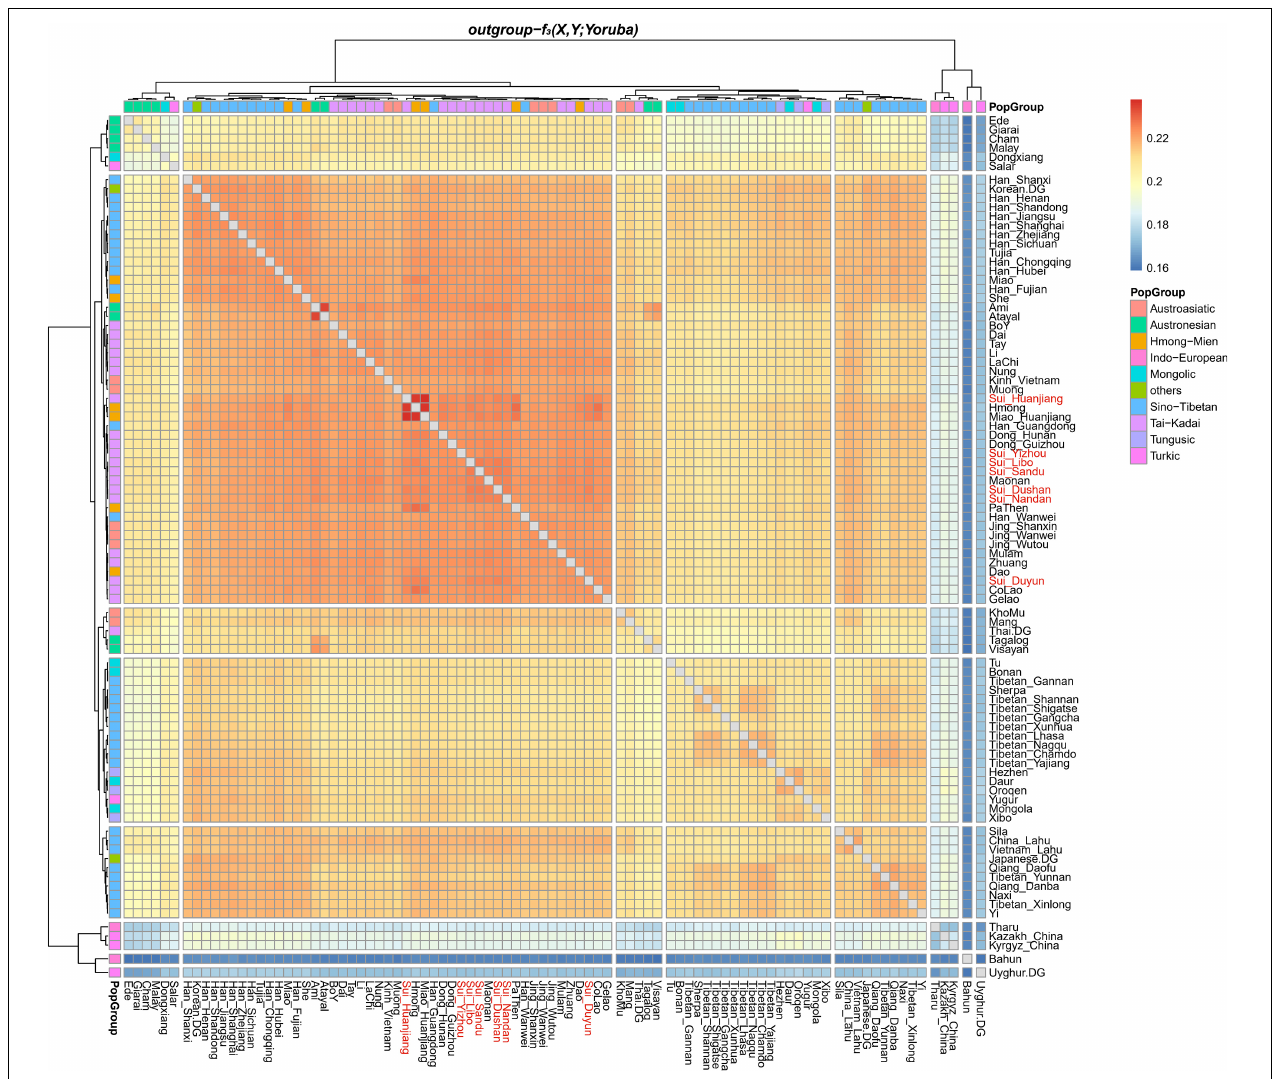
FIGURE 4 | Heatmap showed the sharing genetic drift between the present-day East Asians estimated via outgroup-f 3 (modern East Asian 1, modern East Asian2; Yoruba) . Red indicated more shared genetic drift among the pairwise populations since their divergence from an African outgroup